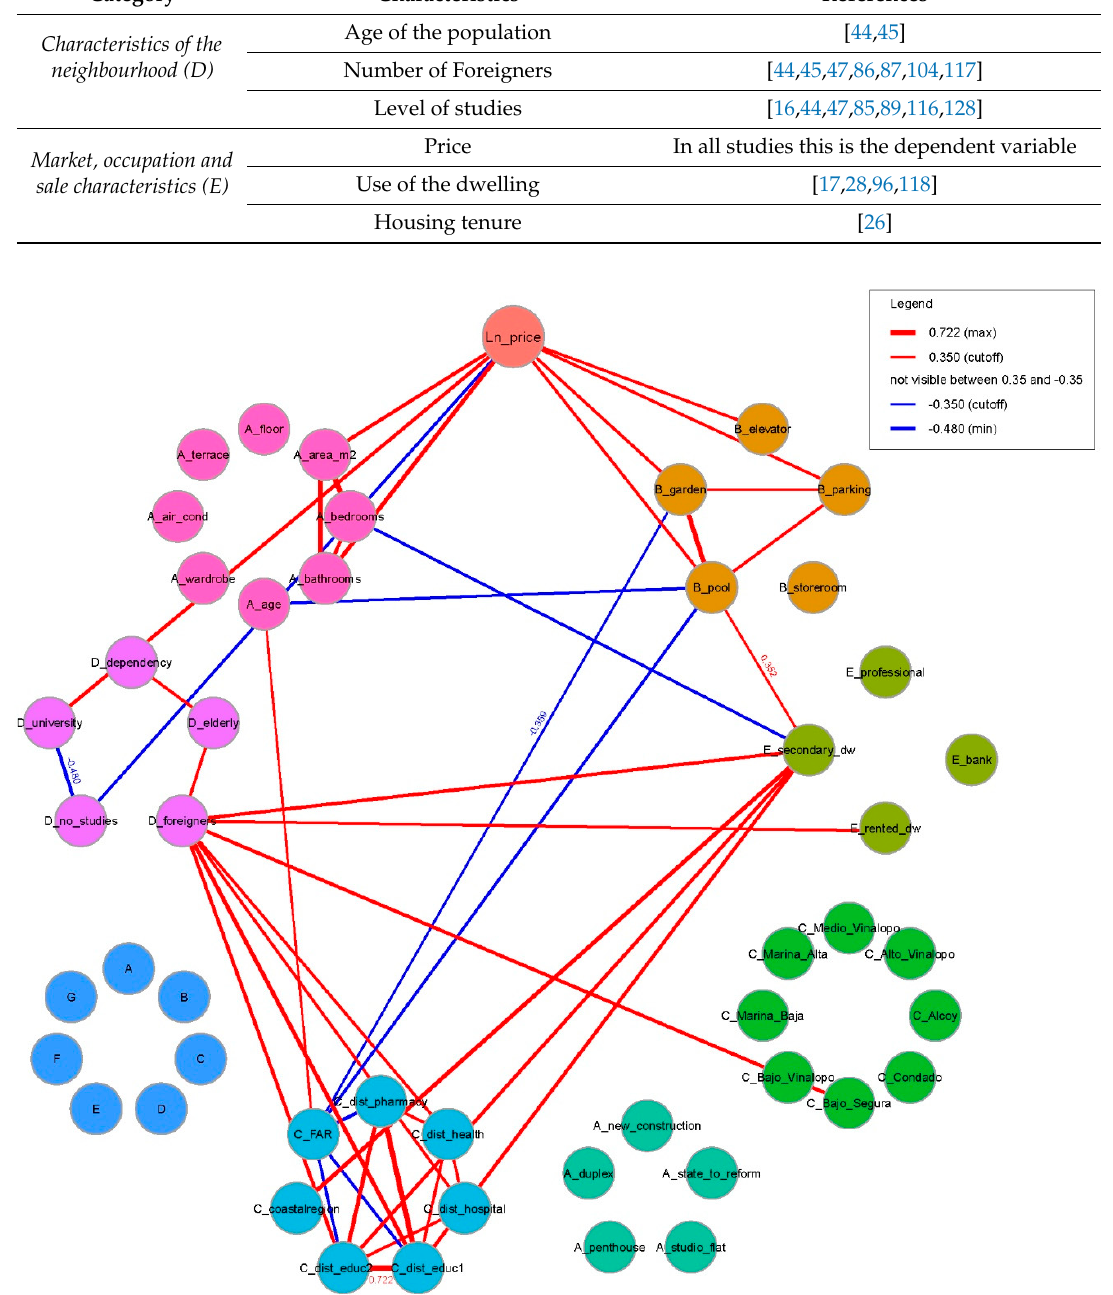
Figure A1. Correlation between the characteristics of the properties—independent variables—and the asking prices. Only correlations greater than 0.35 (in absolute value) are shown.